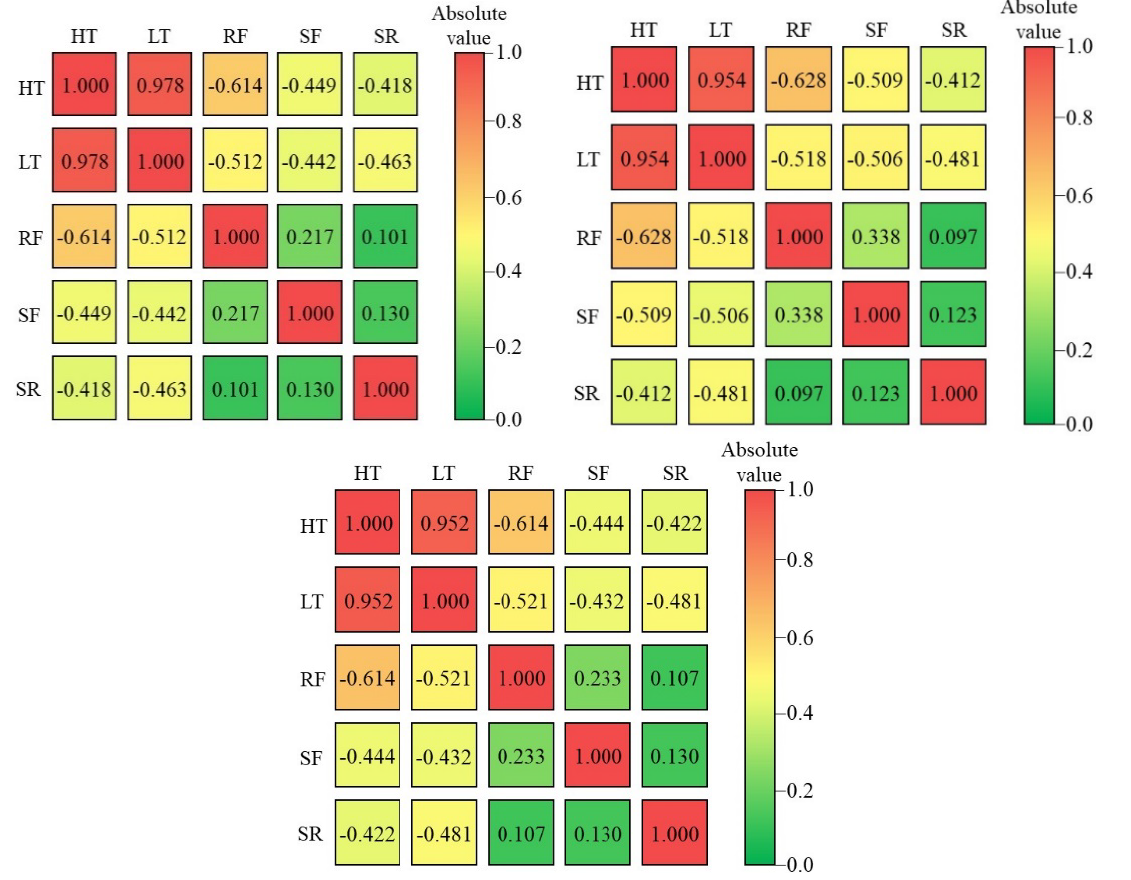
Figure 9. Correlation − map of HT, LT, RF, SF and SR in the study areas. Table 1. Performance evaluation indices for M1–M6 models in training